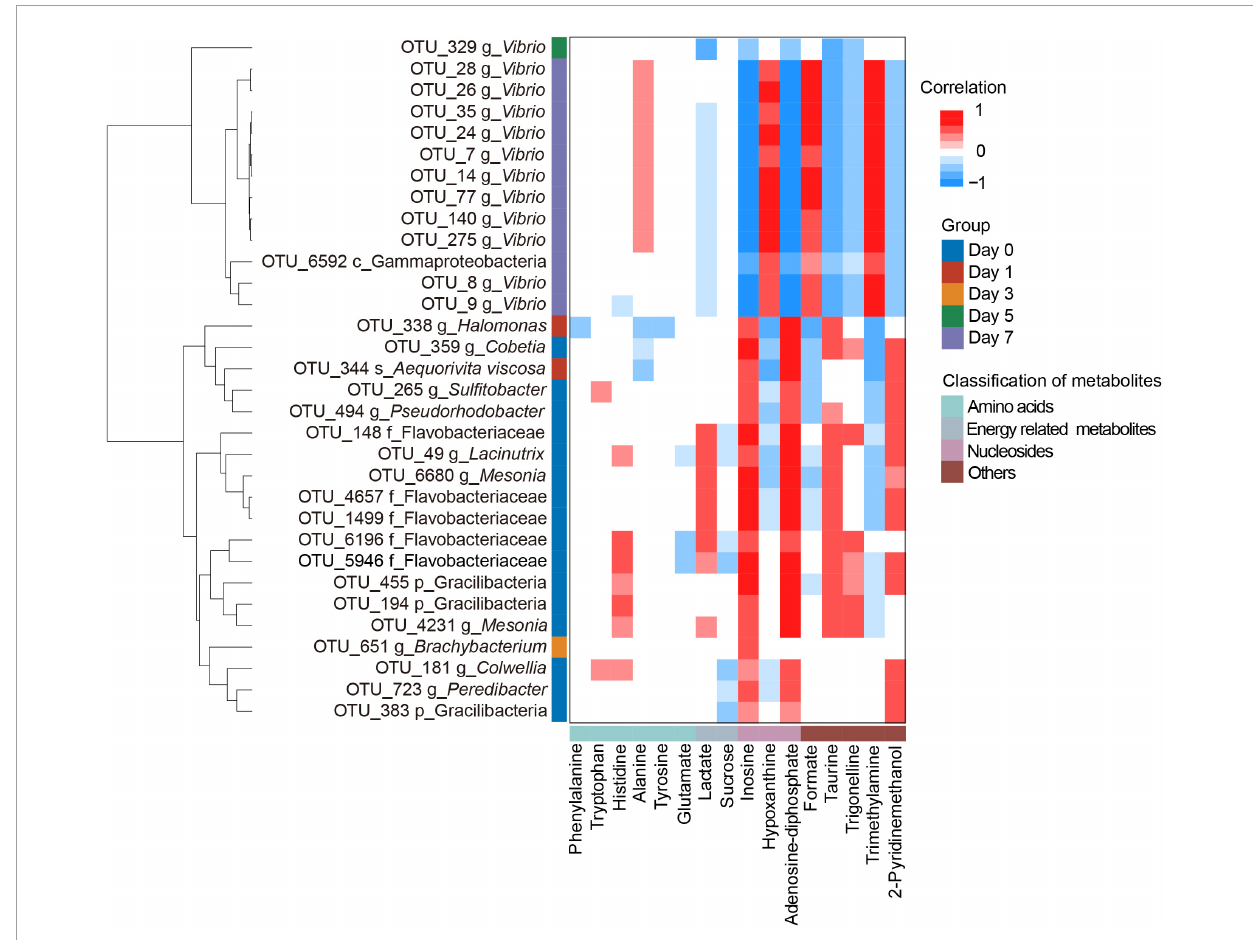
FIGURE4 Clustering heatmap showing the Spearman’s correlations between the indicative bacterial operational taxonomic units (OTUs) and the significantly changed metabolites, with red and blue indicating significant positive and negative correlations,